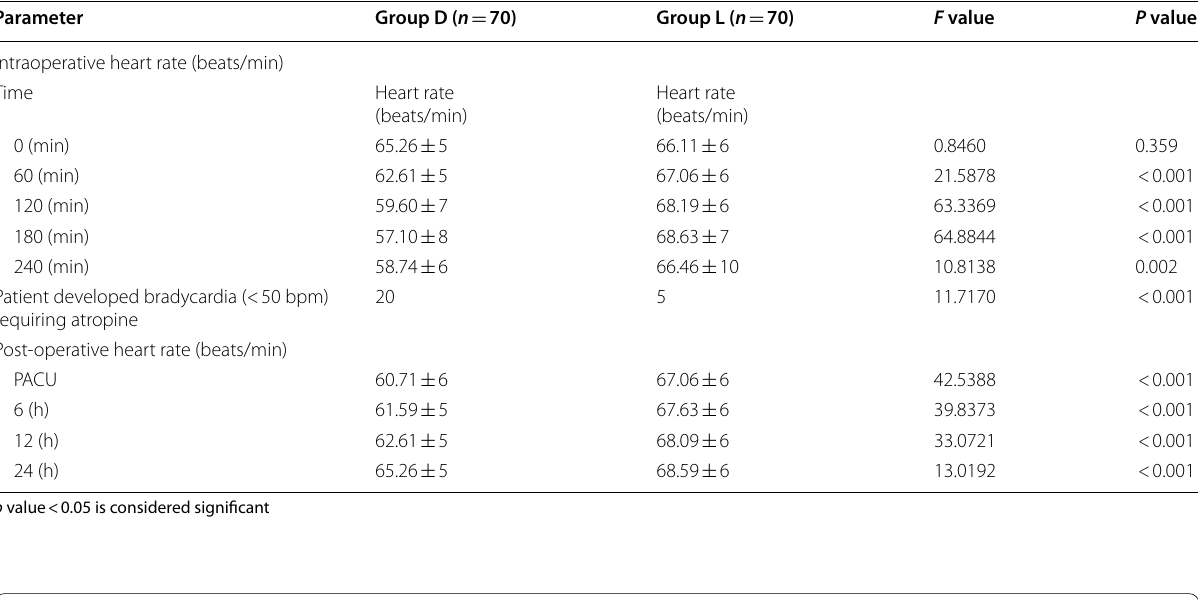
Table 2 Comparison between the intraoperative and post-operative heart rate in the two groups